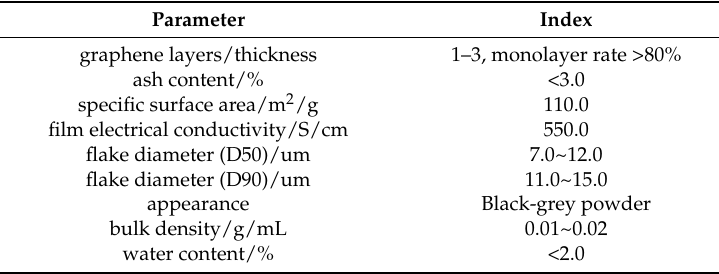
Table 2. Parameters of graphene NK-1.